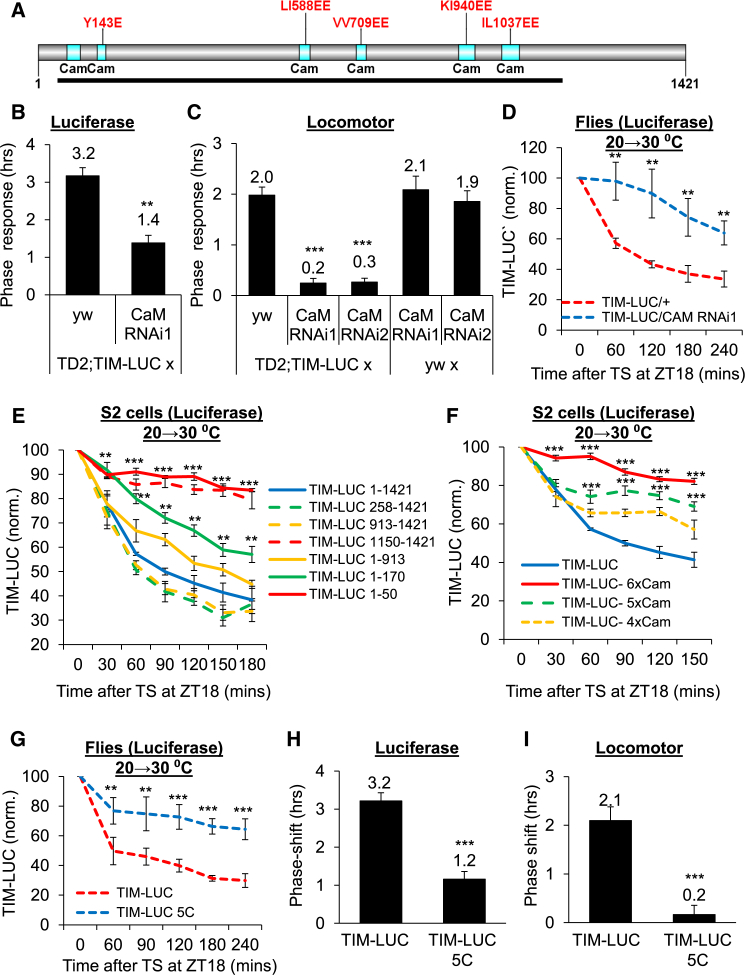
The Effects of Temperature on TIM Stability and the Circadian Clock Are Mediated by CaM(A) TIM harbors six putative CaM binding sites (blue) that are distributed among amino acids 64–1057 (black bar). Mutations to abolish CaM binding are indicated (red).(B and C) In vivo CaM downregulation using two non-overlapping RNAi blocks thermal phase advances in the periphery (B) and brain (C).(D) CaM RNAi (blue) causes reduced TIM degradation in response to TS.(E) N- and C-terminal deletion of TIM results in progressive thermal stabilization in Drosophila S2 cells.(F) Mutations of at least five CaM binding sites on TIM (TIM-LUC 5C) are required to reduce strongly TS-induced TIM degradation in S2 cells, due to redundancy.(G) A TIM-LUC 5C mutant, which lacks the five C-terminal CaM-binding sites, also shows diminished thermal degradation in vivo.(H and I) TIM-LUC 5C acts as a dominant negative and blocks thermal phase advances in the peripheral (H) and brain clocks (I). Error bars represent SD for (B), (C), (H), and (I) or SEM for (D)–(G). p < 0.01 or p < 0.001 from at least five independent experiments (n ≥ 6 each) is indicated with “∗∗” or “∗∗∗,” respectively. Significance for less stable mutants is not shown to keep the figures clear.See also Figure S3.